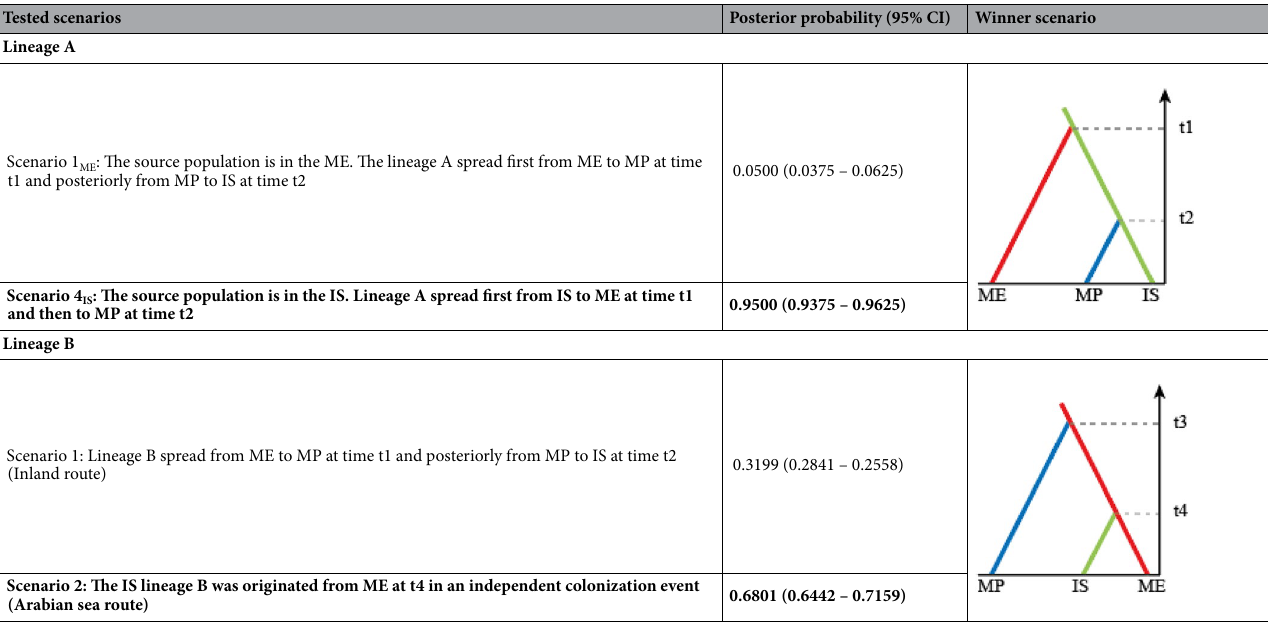
Table 2. Bayesian posterior probabilities for each tested scenario using DIYABC v2.1 for lineages of A and B of domestic sheep. For each lineage, the winner scenario has the highest probability highlighted in bold. Only the winner scenario for each lineage was graphically represented. Colours represent the populations: ME (the Middle East, red), MP (the Mongolian Plateau, blue) and IS (the Indian subcontinent,